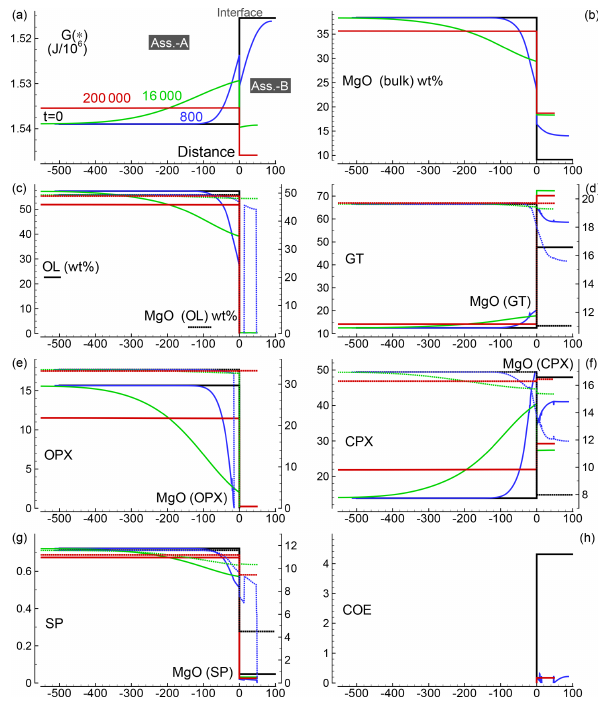
Figure 2. Solution of a 1-D model simulation. The initial propor- tion of the two assemblages is 1 : 1. (a) G(A ∗ ) and G(B ∗ ) at three different times and at time zero when the two assemblages sepa- rately are considered in chemical equilibrium. (b) Local bulk MgO (wt%) retrieved from the relation with G( ∗ ) . All the other oxides are retrieved with similar relations. The units of the oxides is weight percent (wt%), which is equivalent to the mass of the components in grams with respect to a total mass of 100g. (c–g) Mineral abun- dance (solid lines) and MgO content (dotted lines) in the corre- sponding minerals. (h) Distribution of coesite. Local mineral abun- dances and compositions shown in panels (c) – (h) are retrieved after performing thermodynamic computations at every spatial location with the program AlphaMELTS using the bulk oxide abundance ex- emplified in (b) for MgO. An animation file and complete data for all nine oxides are available following the instructions in the Sup- plement. Time and distance in arbitrary units. Pressure and temper- ature are fixed at 40kbar and 1200 ◦ C. The rest of the parameters for the model are defined in the main text.